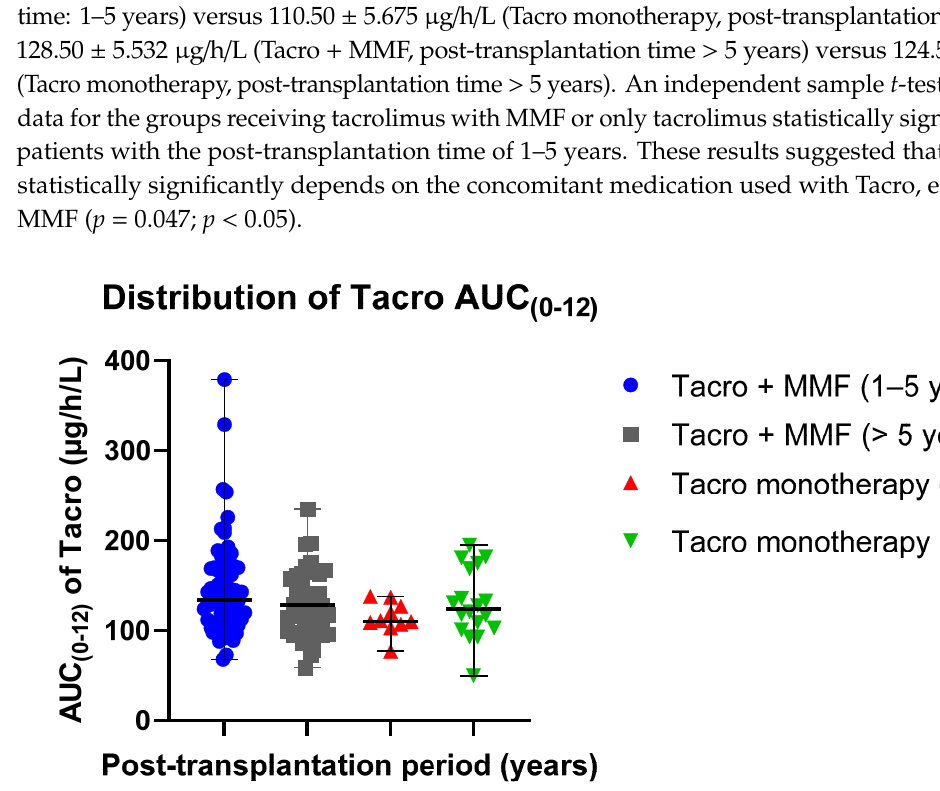
Figure 2. Distribution of the Tacro AUC (0–12) exposure values in the study groups: Tacro + MMF and Tacro monotherapy; MMF—mycophenolate mofetil; Tacro—tacrolimus. Scatter plots display the individual AUC (0–12) exposure values’ distribution from the median in the Tacro-receiving study groups (median ± SE): 134.00 ± 6.251 µ g / h / L (Tacro + MMF, post-transplantation time: 1–5 years) versus 110.50 ± 5.675 µ g / h / L (Tacro monotherapy, post-transplantation time: 1–5 years); 128.50 ± 5.532 µ g / h / L (Tacro + MMF, post-transplantation time > 5 years) versus 124.50 ± 8.978 µ g / h / L (Tacro monotherapy, post ‐ transplantation time > 5 years). Respectively, mean values (mean ± SD) were as